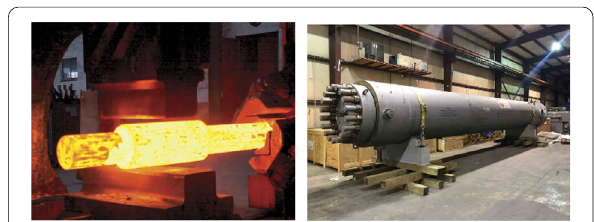
Figure 2 Forgings of the tube connecting section and shaft parts